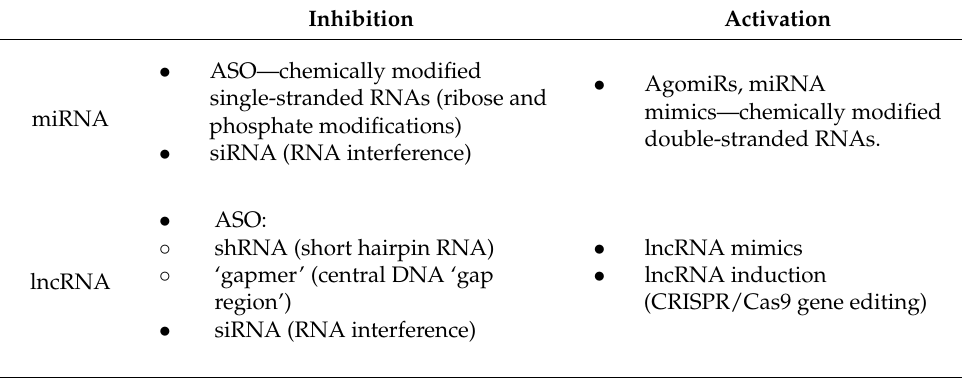
Table 1. Methods of therapeutics targeted at miRNA and lncRNA. Based upon References